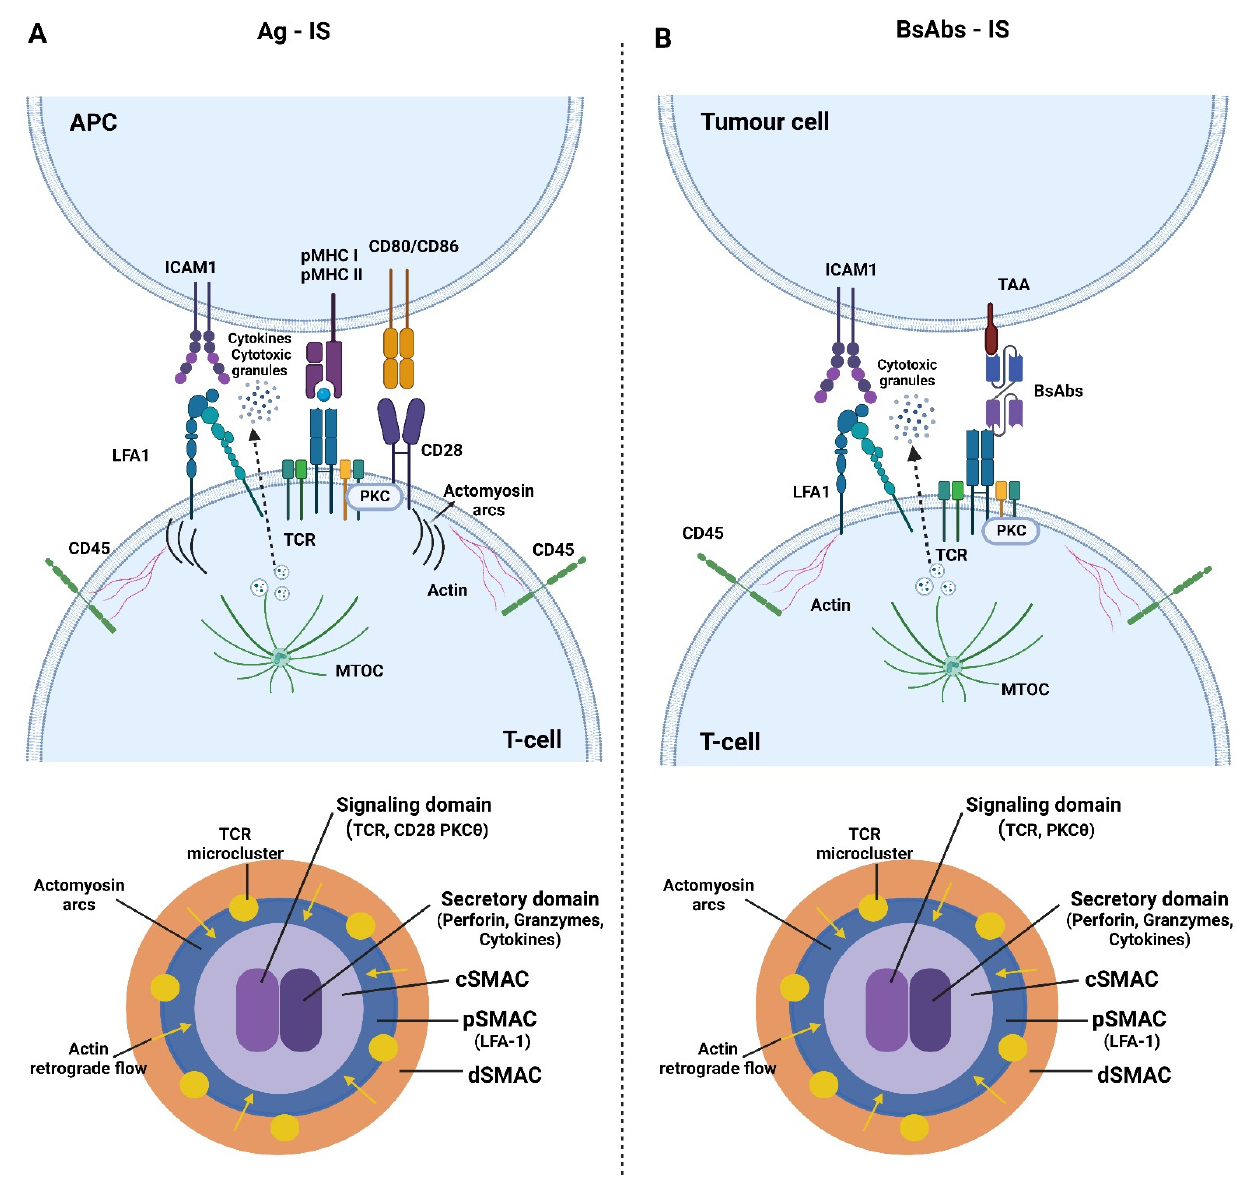
Figure 1. Immunological synapse assembled in response to antigen or bsAbs. ( A ) Schematic of the canonical IS assembled between a T cell and an APC presenting an antigenic peptide bound to the major histocompatibility complex (pMHC). pMHC I and II are indicated. However, for clarity, it is only represented the MHC class I. The main activating molecules, cytoskeleton components, and secretory granules or cytokines delivered at the contact interface are depicted in the upper panel. The principal components of the cSMAC, pSMAC, and dSMAC are indicated in the lower schematic. The signaling domain located in the cSMAC contains TCR microclusters (MCs), co-stimulation molecules such as CD28 and PKC θ . The secretory domain of the cSMAC secretes perforin- and granzyme-containing granules in the IS assembled by cytotoxic T cells and different types of cytokines in the IS assembled by helper T cells. ( B ) Schematic of the topology of the IS assembly induced by bsAbs between a T cell and a tumor cell. BsAbs typically engage the T cell by the CD3 ε chain of the TCR and the tumor cell through a TAA. This leads to the establishment of antigen-stimulated canonical IS. Upper panel shows the main elements of the IS induced by bsAbs. The cSMAC, pSMAC, and dSMAC compositions are represented in the lower schematic. The signaling domain located in the cSMAC contains TCR MCs and signaling proteins such as PKC θ . Secretory domain of the cSMAC secretes lytic granules containing perforin and granzyme B.